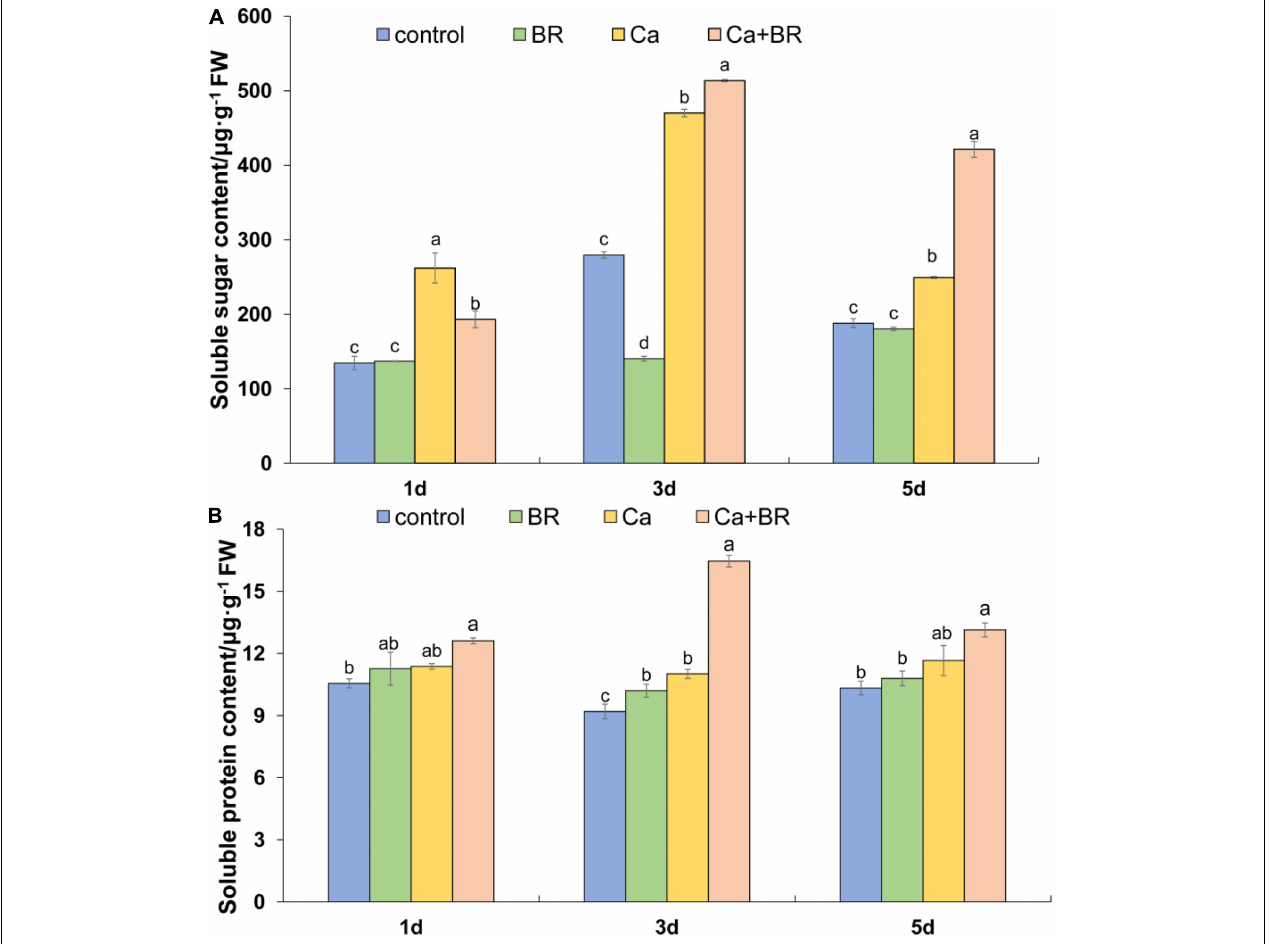
FIGURE 9 | (A) Soluble sugar and (B) soluble protein content in the leaves of tomato seedlings subjected to Ca(NO 3 ) 2 , foliar spraying with BR, or their combinations. BR, 0.1 µ mol/L brassinolide; Ca, 100 mmol/L Ca(NO 3 ) 2 ; Ca+BR, 100 mmol/L Ca(NO 3 ) 2 stress plus foliar spraying with exogenous BR. Each data point represents the mean of three independent biological replicates (mean ± SD). Different letters above the bars indicate statistically significant differences ( P <